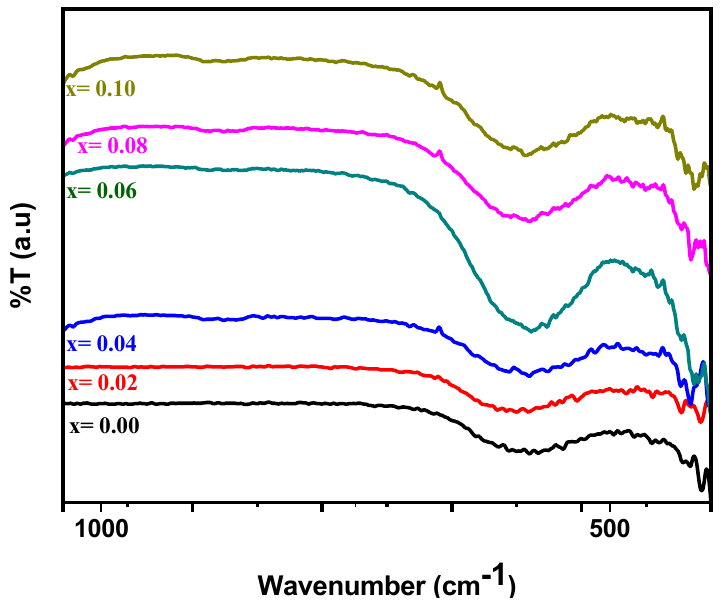
Figure 2. Fourier transform infrared (FT-IR) spectra of the Co 0.5 Ni 0.5 Nb x Fe 2 − x O 4 (0.0 ≤ x ≤ 1.0) nanoparticles.